Question: Give a one-sentence summary of this figure.
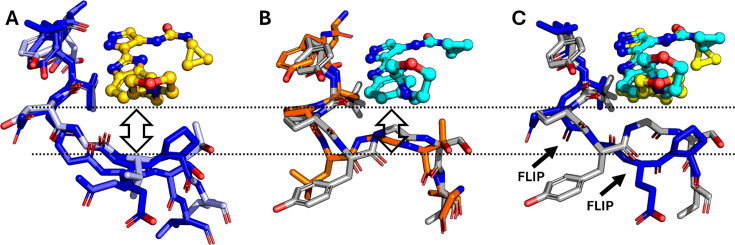
Answer: Structural basis for improved inhibitor selectivity. The hinge region of Pkn kinases differs from human kinases, and these differences can be utilized in drug design. ( A ) Superposition of PknA–AT9283 complex, PknB (PDB ID: 1O6Y), and PknG (PDB ID: 4Y0X) crystal structures (different shades of blue) show similar backbone orientation and a large distance from AT9283 (yellow). ( B ) Superposition of JAK2–AT9283 complex (gray) and Aurora A kinase (orange, PDB ID: 1MQ4) shows tight packing of the hinge against the inhibitor (cyan). ( C ) Comparison of PknA–AT9283 (gray) to JAK2–AT9283 (blue) complexes. Arrows indicate positions of main-chain flips leading to a different hinge orientation.